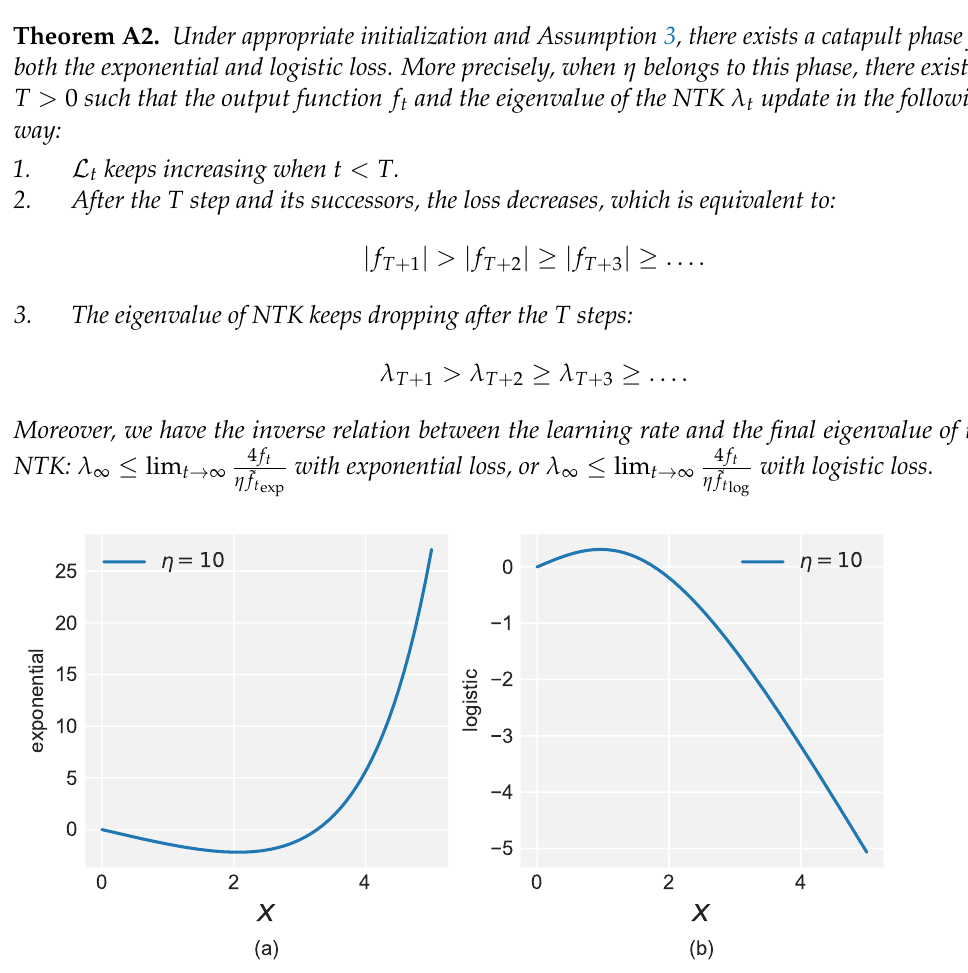
Figure A1. Graph of φ ( x ) for the two losses. ( a ) Exponential loss with learning rate η = 10. ( b ) Logistic loss with learning rate η =